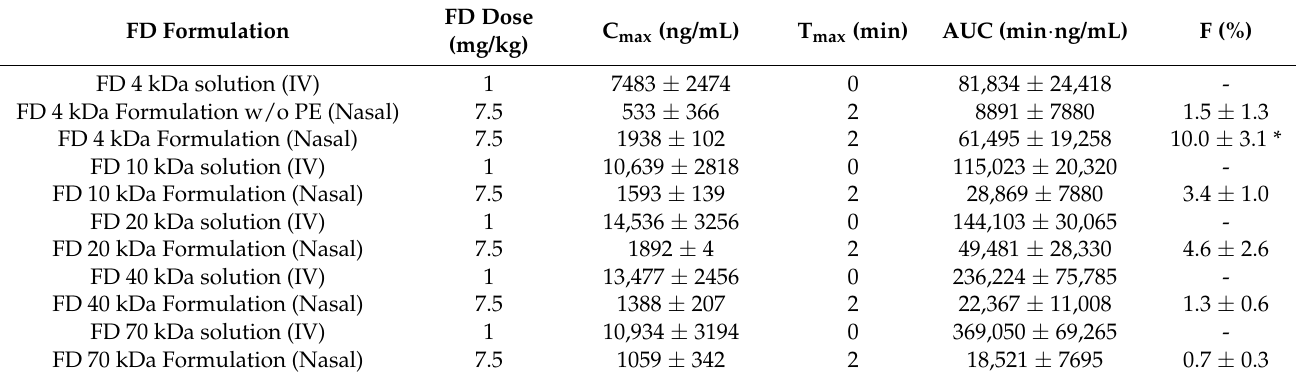
Figure 7. Comparison of the nasal bioavailabilities of FITC-labeled dextrans with different molecu- lar weights and fitting insulin into the trend obtained with dextrans. Table 5. Pharmacokinetic parameters obtained for the various FITC-dextrans loaded SFDs. FD Formulation